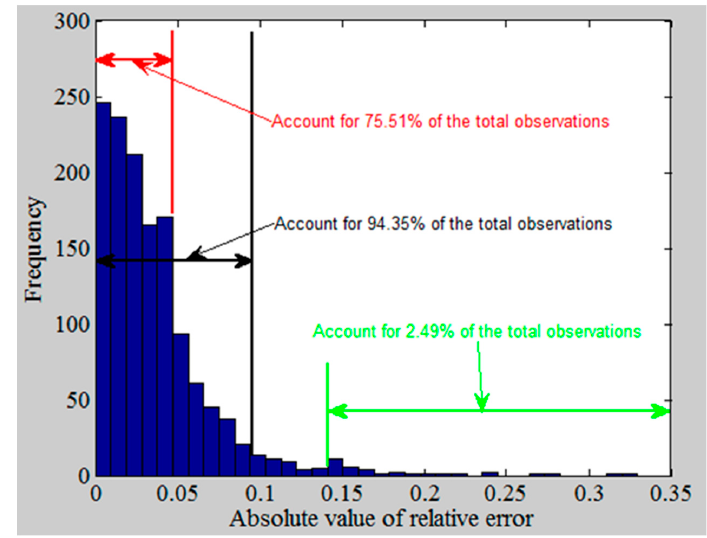
Figure 3. Distribution of relative errors of the province’s industrial structure.